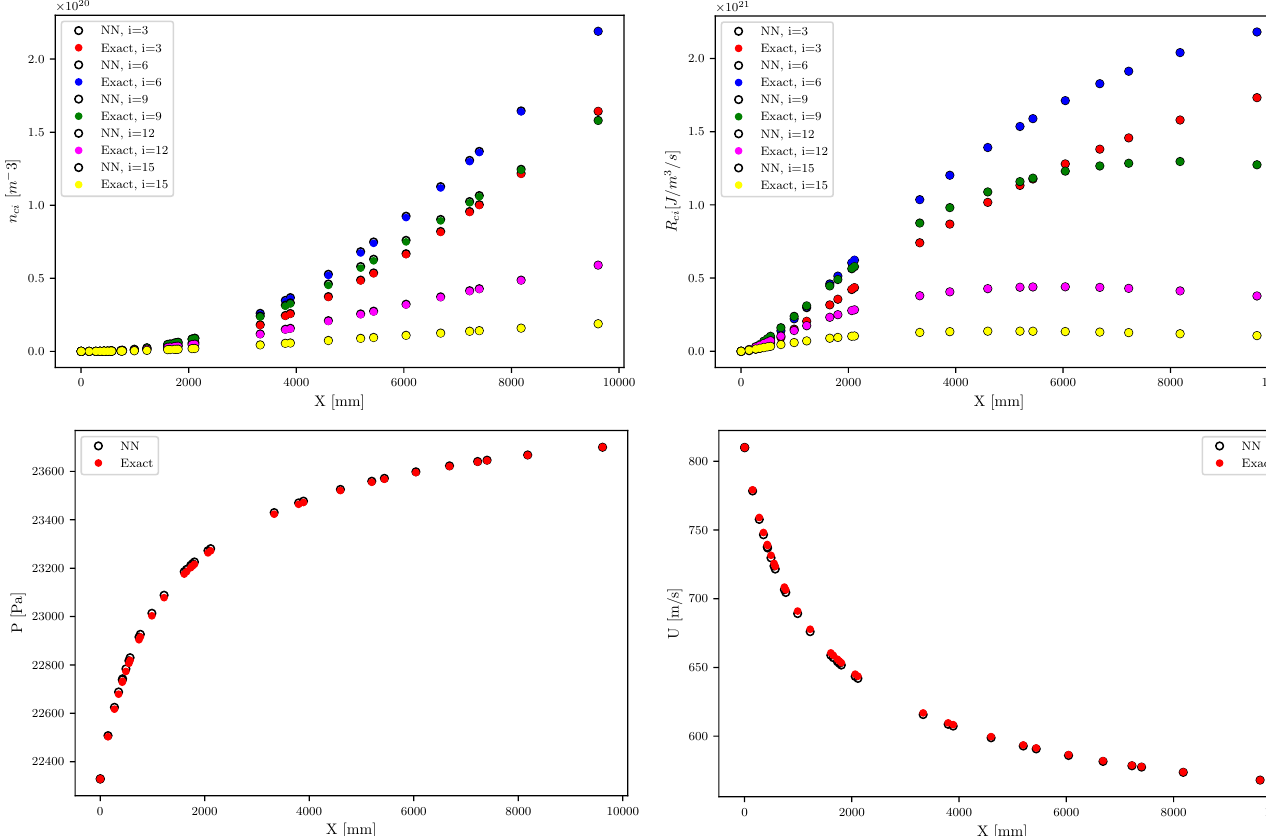
Figure 8. Solution of the state-to-state 1D shock flow relaxation inferred by